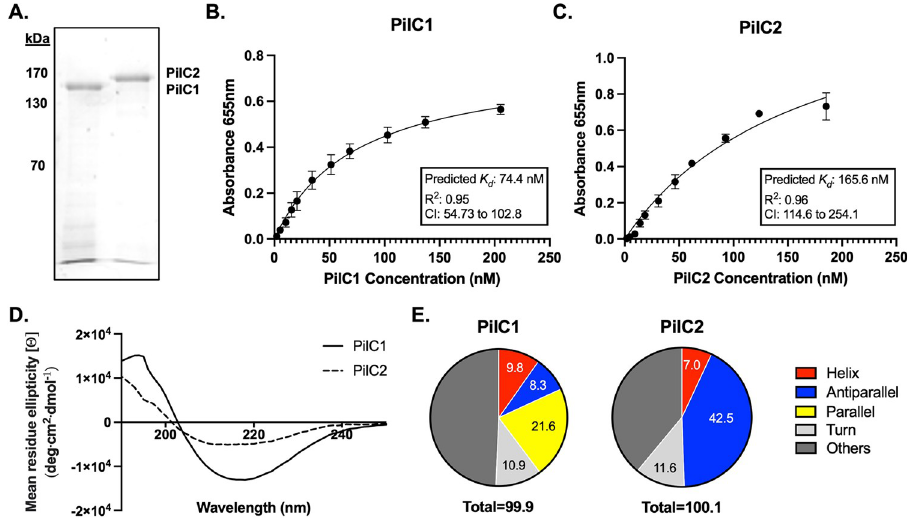
Fig 2. PilC1 and PilC2 are adhesins with distinct protein structures. (A) Recombinant PilC1 and PilC2 were purified and separated on a 7.5% SDS PAGE gel and stained with Coomassie blue. Proteins were added to monolayers of Chang epithelial cell of HeLa origin at increasing concentrations in 50 mM Tris-HCl, pH 8.5. (B, C) Adherence was detected by ELISA using polyclonal antiserum CHP-GP7 for PilC1 (B) or GP103 for PilC2 (C) and a secondary anti- guinea pig antibody conjugated to horseradish peroxidase (HRP). Non-linear regressions were fit using the GraphPad Prism one site specific binding model fit to total data from 3 independent runs, and the K d was calculated based on the regression. Error bars represent standard error of the mean, n = 3. (D, E) Circular dichroism was carried out on purified PilC1 and PilC2 (D) and the resultant spectra were used to predict protein secondary structures (E). The CD spectra are representative graphs of three independent analyses carried out on different batches of purified